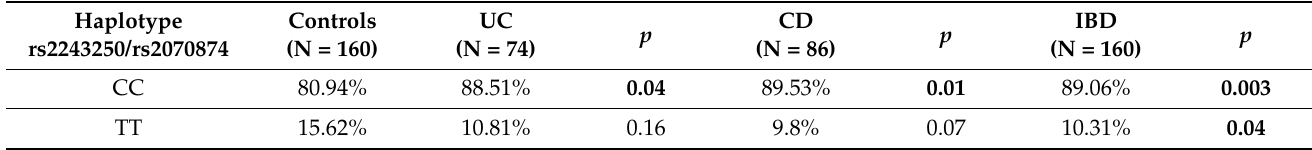
Table 4. Results of IL-4 rs2243250/rs2070874 haplotype analyses for the investigated diseased